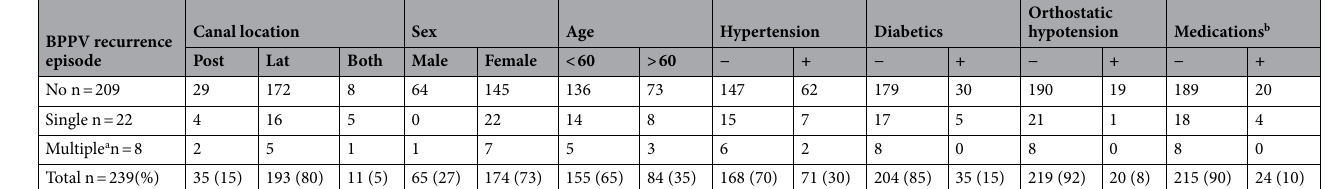
Table 2. Characteristics of the no recurrence, single recurrence, and multiple recurrence groups in BPPV. BPPV Benign paroxysmal positional vertigo, Post posterior canal, lat lateral canal, both involves multiple canal. a Includes seven people who recurred twice and one person who recurred three times. b The diseases of the drug-taking were arrhythmia, heart disease, antidepressant, thyroid disease, hypnotic and prostate